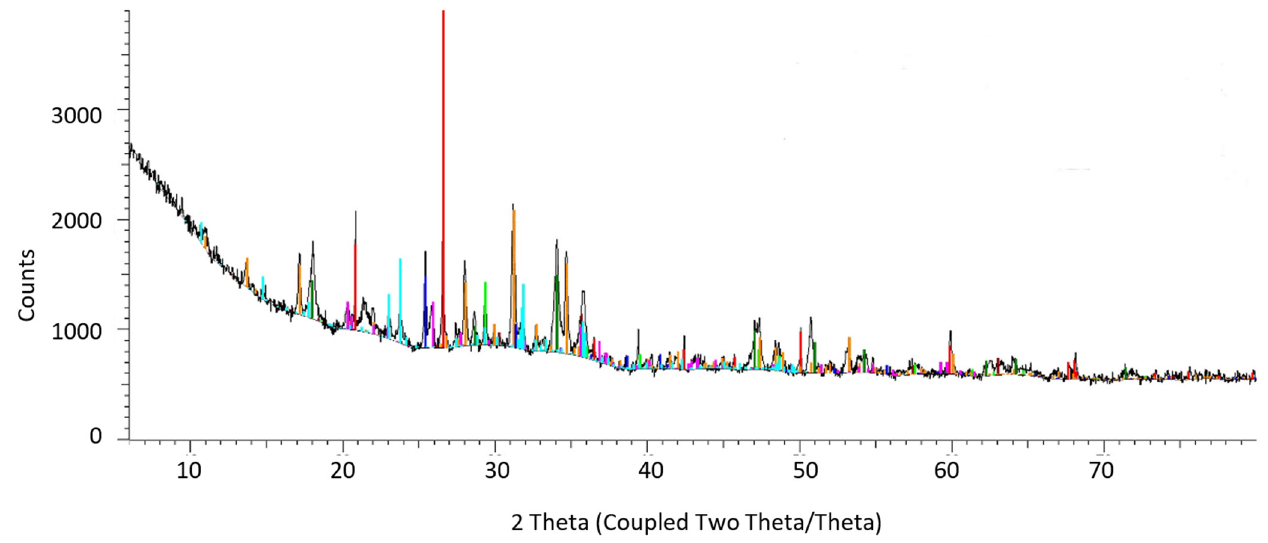
Figure 1. X-ray diffraction spectrum of SS-FA.